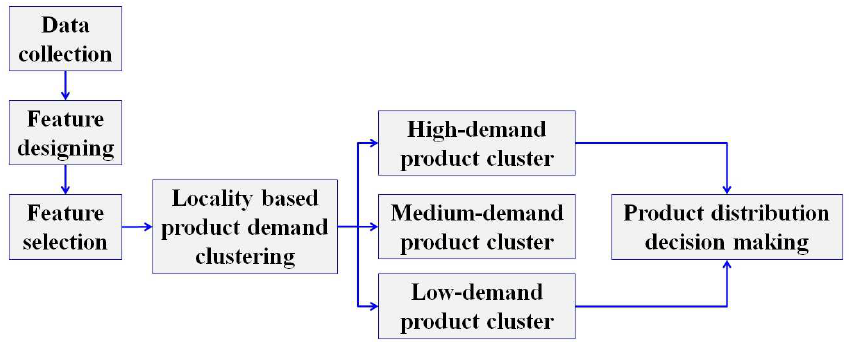
Figure 3. Proposed method work